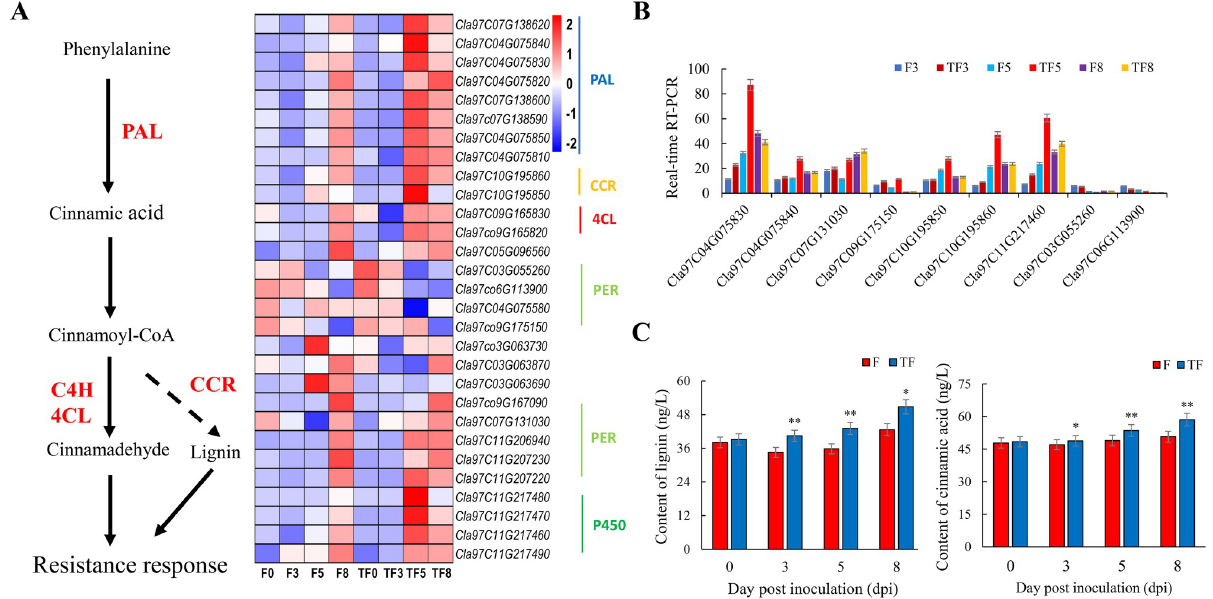
Fig 5. DEGs in phenylpropanoid metabolic pathways were analyzed for T . asperellum M45a biocontrol of Fusarium wilt. Application of T . asperellum M45a (TF). The noninoculated control (F). A: T . asperellum M45a is involved in the regulation of the watermelon phenylpropane synthesis pathway against FON; B: qRT–PCR analysis of the DEGs; C: Effect of T . asperellum M45a inoculation on the activities of lignin and cinnamic acid ( � P < 0.05; �� P <